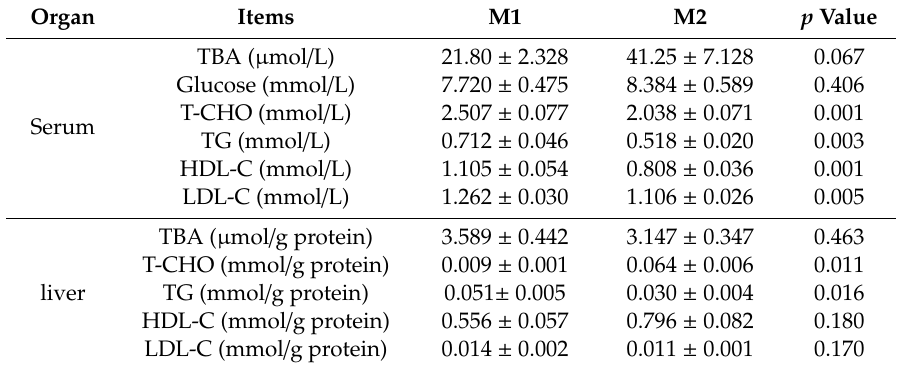
Table 3. E ff ects of feeding frequency on serum metabolites and liver metabolites of growing pigs 1 .